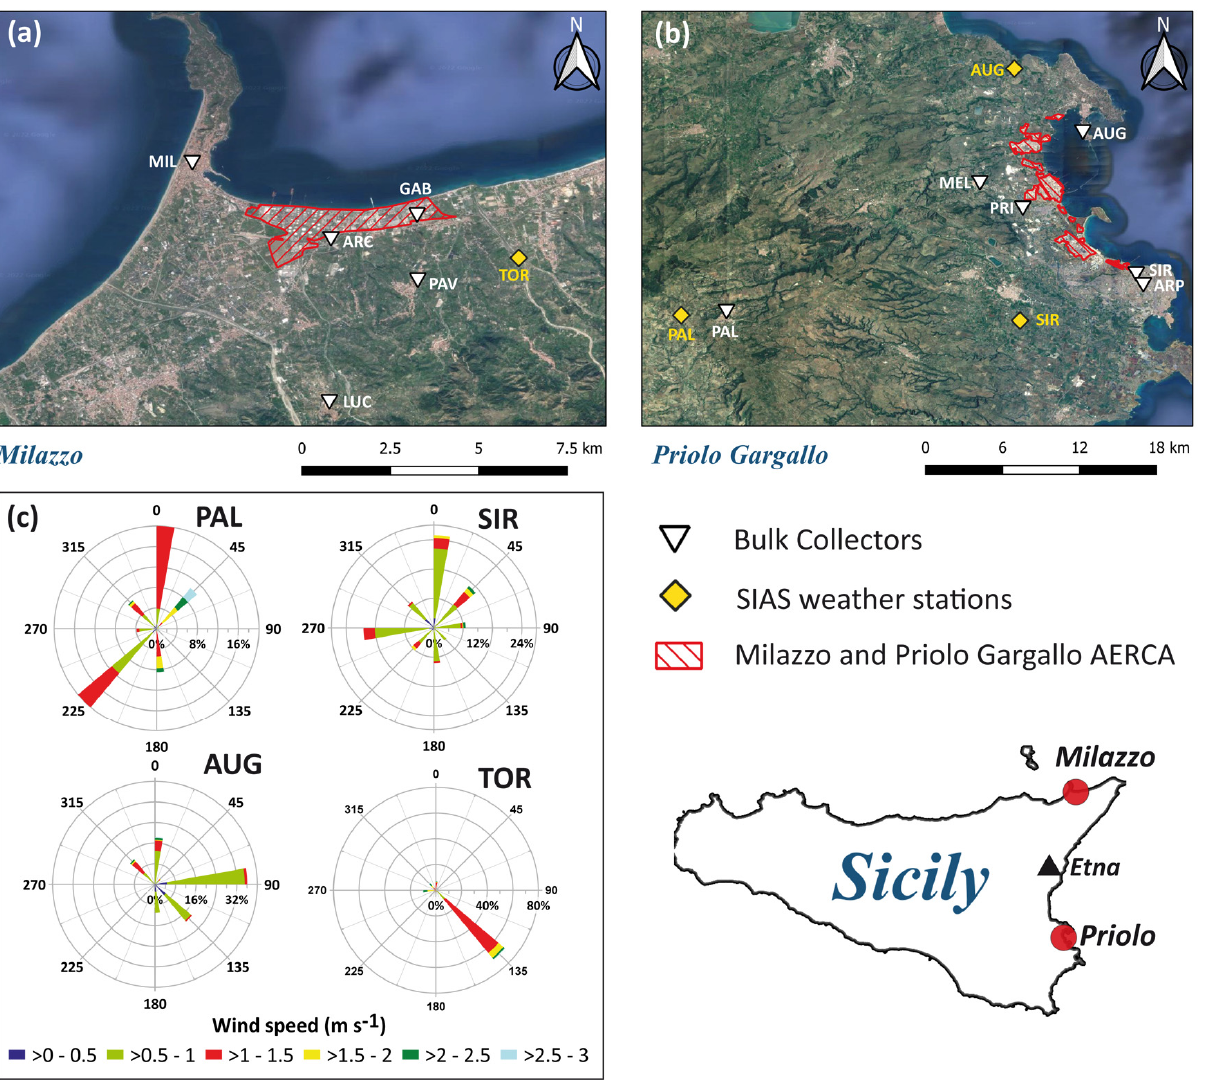
Figure 1. Milazzo AERCA ( a ) and Priolo Gargallo AERCA ( b ) (red dashed areas); location of the SIAS weather station (yellow squares), and monitoring sites (white triangles). Box ( c ) shows the wind speeds and directions recorded at 2 m above the ground at SIAS weather stations. Base map: Google